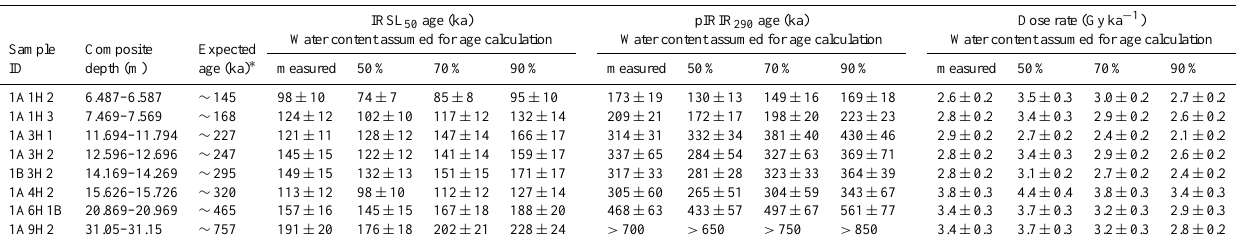
Table 6. Results of the standard SAR-IRSL 50 protocol and the pIRIR 290 protocol. Ages and dose rates are given for various assumed and the measured water contents. All analytical results are presented with their 1-sigma